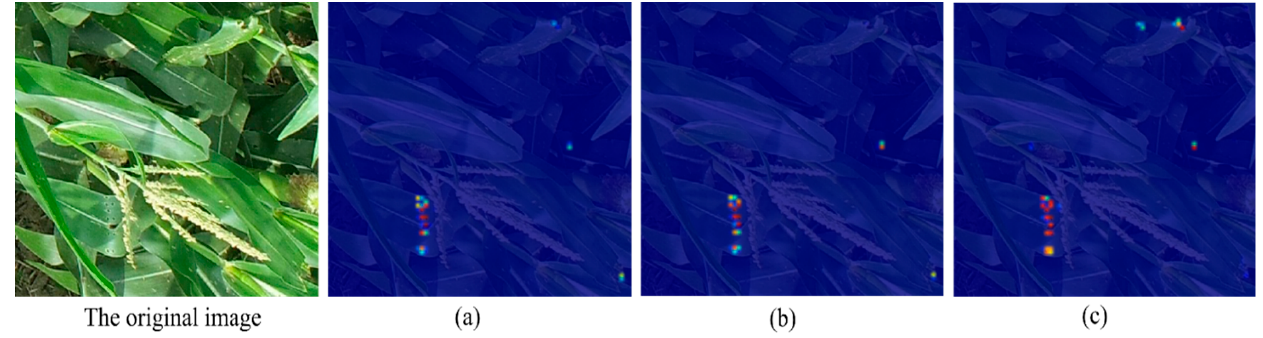
Table 4. Influence of different attention modules on the overall model performance in different